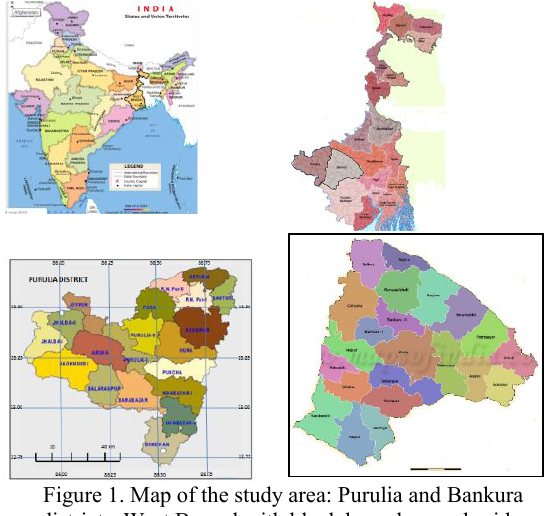
Figure 1. Map of the study area: Purulia and Bankura districts, West Bengal with block boundary and